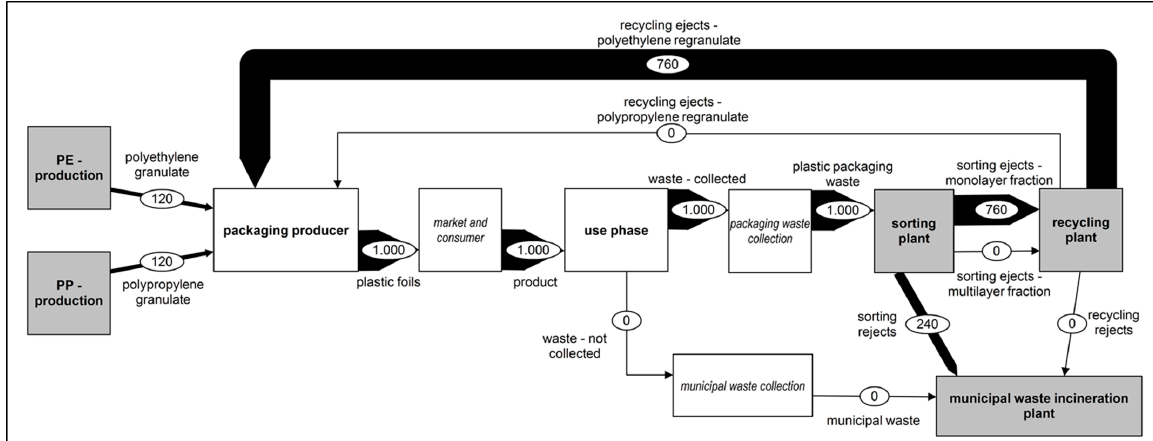
Figure A5. Material flows—Scenario 4—Closed Material Cycle. Figure A6. Material flows—Scenario 5—Recycling Goals 2025.